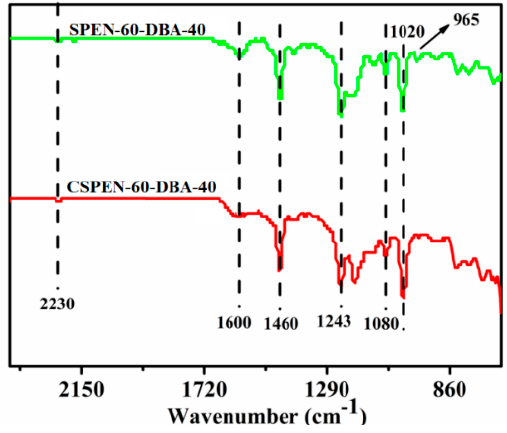
Figure 3. The FT-IR spectra of SPEN-60-DBA-40 and CSEN-60-DBA-40 membranes.